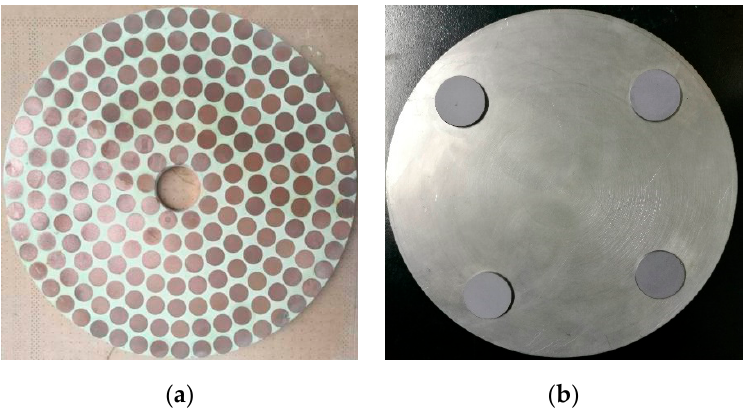
Figure 12. ( a ) The resin bond diamond lapping plate, and ( b ) the distribution of workpieces on the fixture.